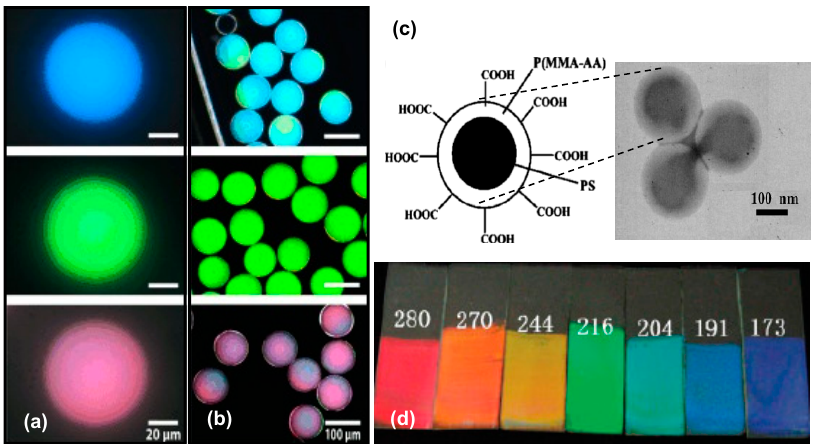
Figure 4. ( a , b ) Three structural colors (blue, green, and red) of photonic microcapsules prepared with various shell thicknesses of core-sheath particles under optical micrographs. ( a ) bright-field, ( b ) dark-field. Reprinted with permission from [68] Wiley-VCH Verlag GmbH & Co. KGaA, Weinheim, 2014;